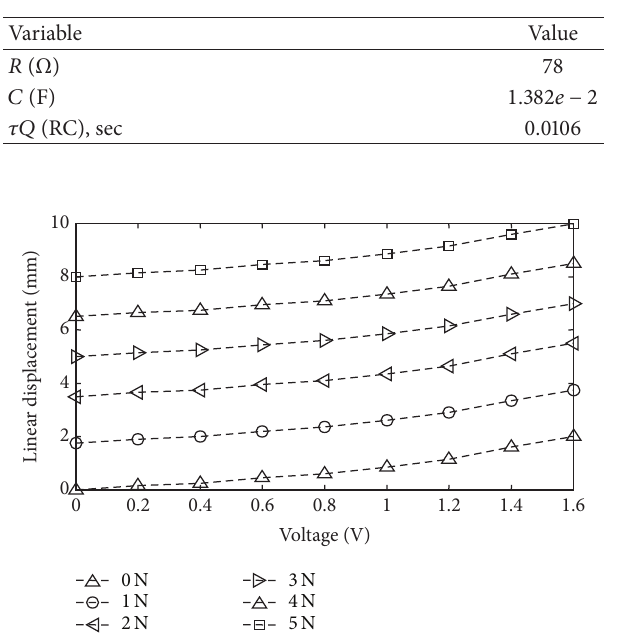
Figure 7: Voltage-elongation and force-elongation relationships of the EAP actuator.